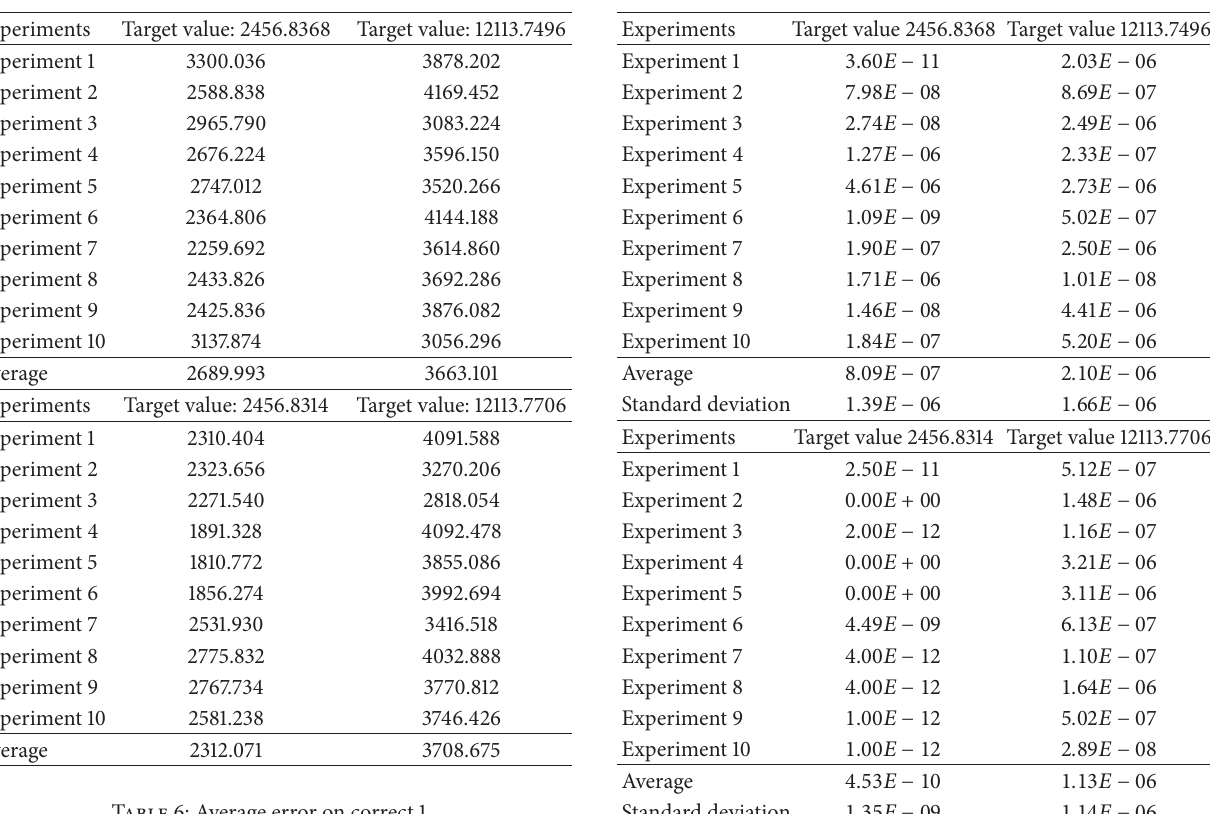
Table 7: Average error of test set.